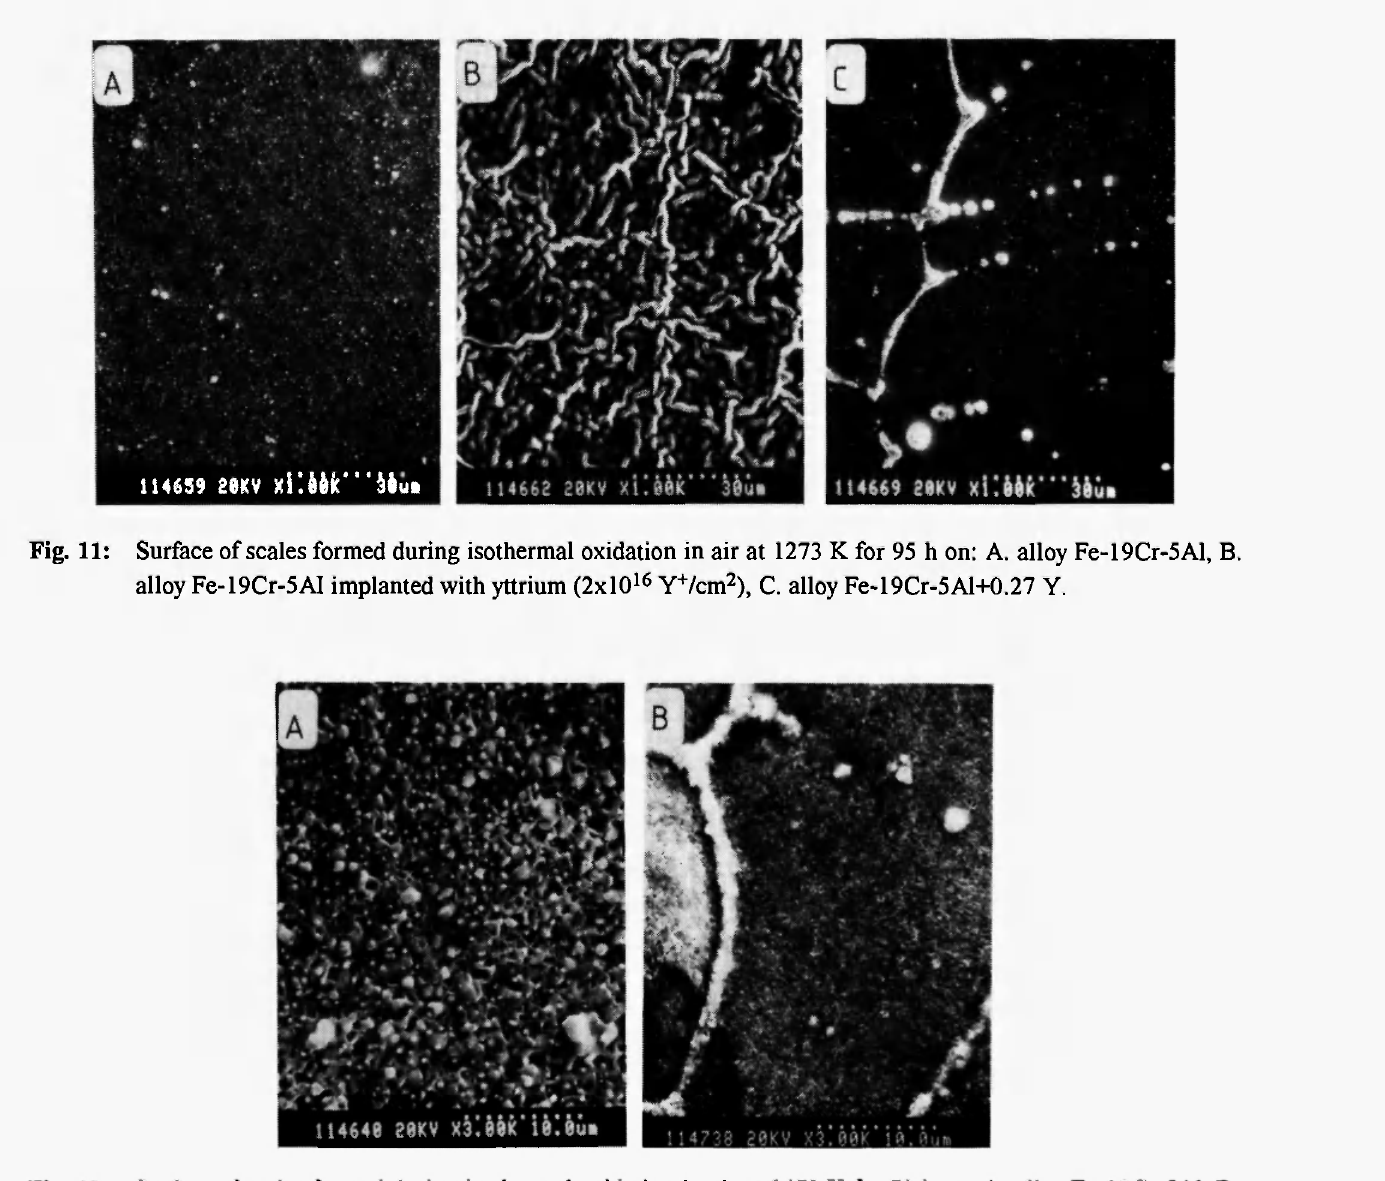
Fig. 12: Surface of scales formed during isothermal oxidation in air at 1473 Κ for 70 h on: A. alloy Fe-19Cr-5Al, B. alloy Fe-19Cr-5Al + 0.27Y.